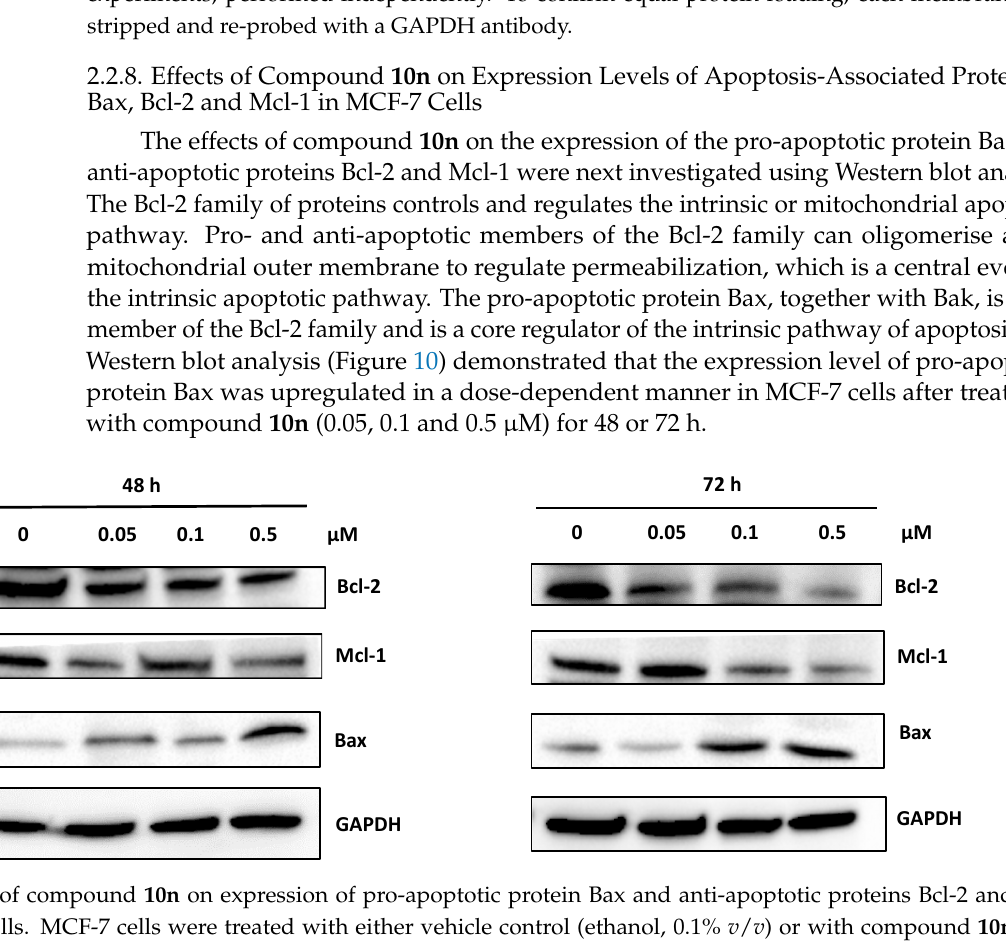
Figure 9. Effects of compound 10n on the inhibition of the bisthioalkylation of Cys239 and Cys354